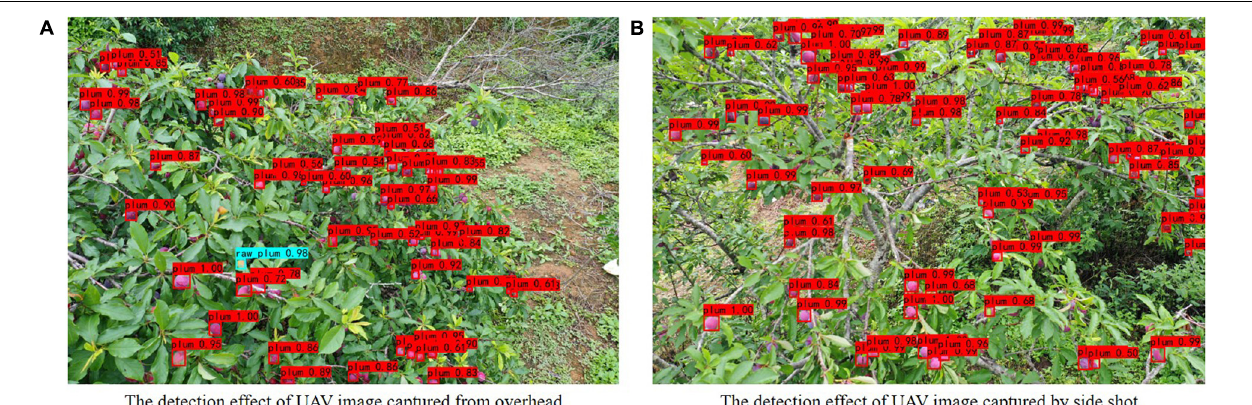
FIGURE 9 | The detection effect of unmanned aerial vehicle (UAV)